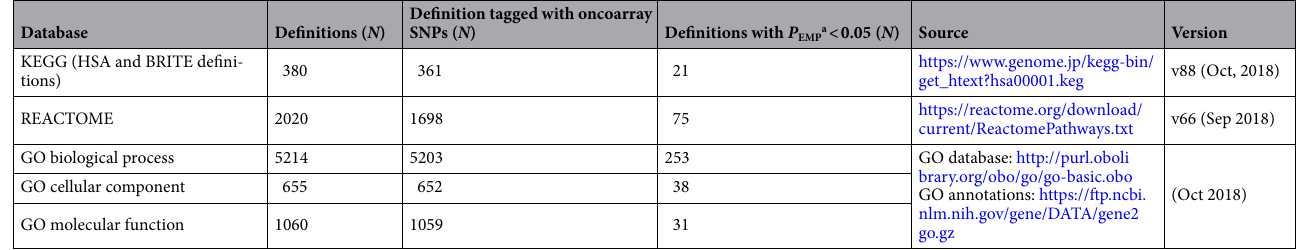
Table 3. Pathway definitions used in the pathway-level analysis. a Empirical p-value of the association test with DTC risk at the pathway